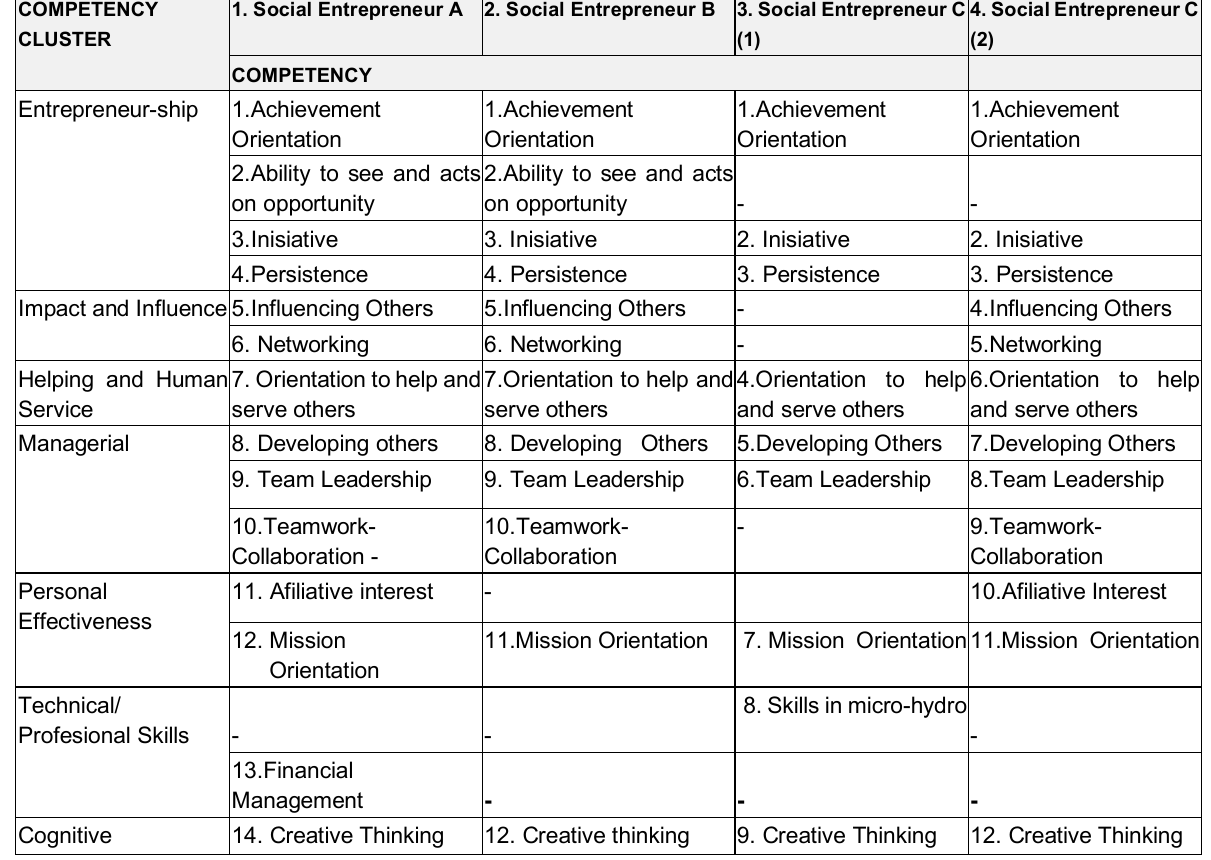
Table 1: Cross cases data on Competencies of Social